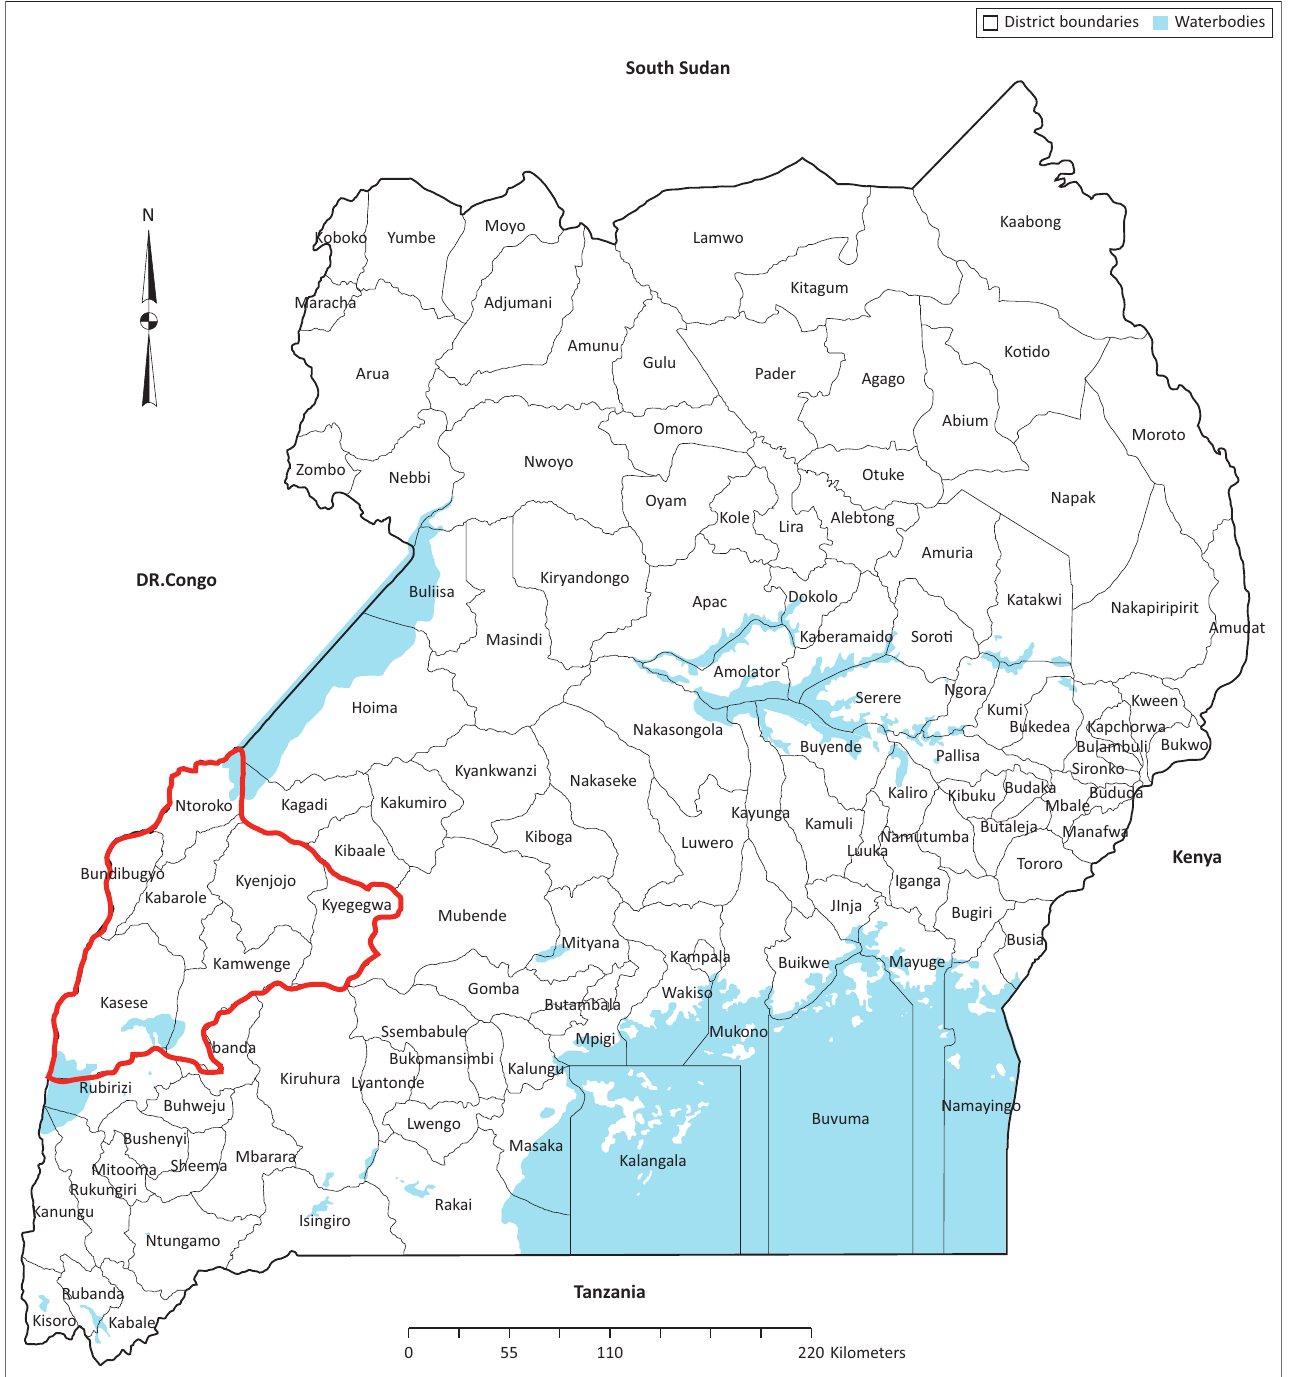
FIGURE 1: Map from Uganda Bureau of Statistics 2014 Census, relevant districts outlined in red.